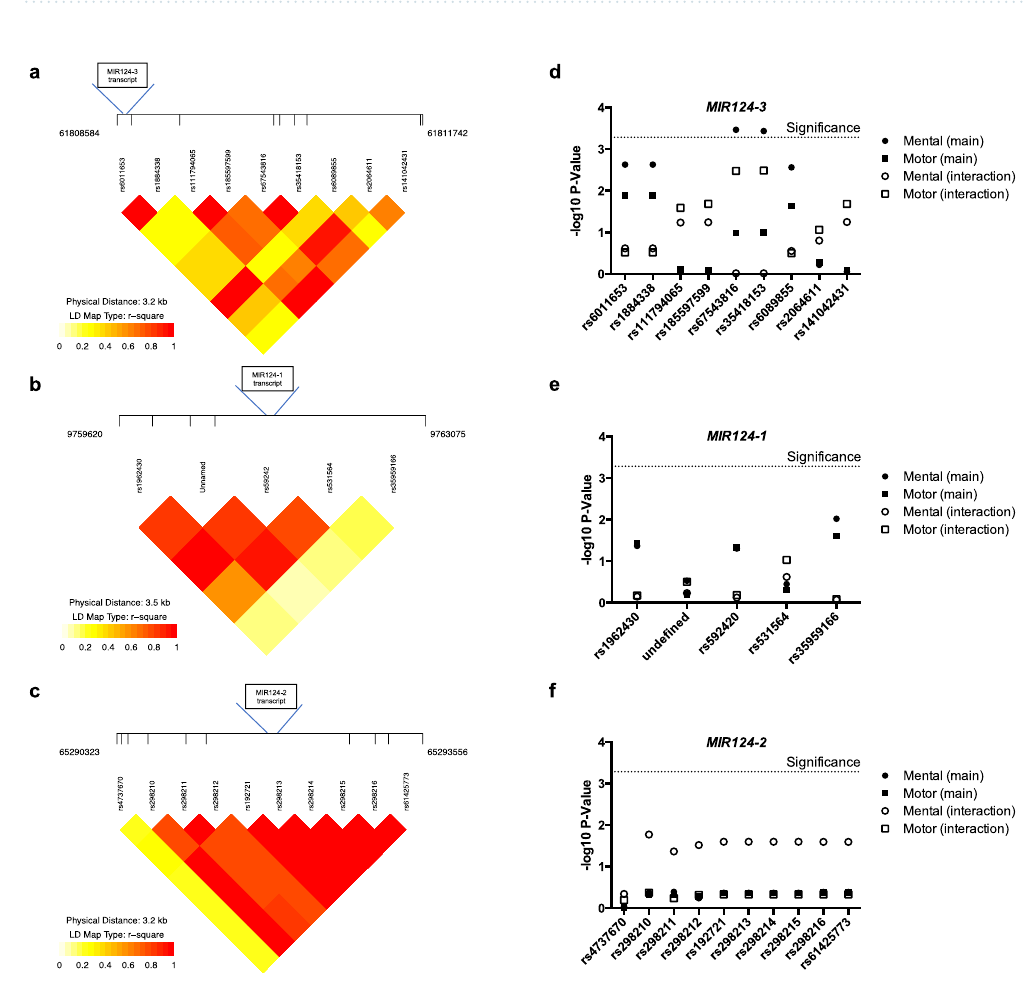
Figure 4. Association analysis of miR-124 SNPs with neurodevelopment phenotypes. ( a–c ) Schema of SNPs in relation to the genomic locus of miR-124-1, − 2, and − 3. Linkage disequilibrium (LD) patterns around miR-124 in the study population are shown. LD plot reflects pairwise R 2 among SNPs. ( d–f ) Negative log10 p-values for SNP associations with the mental composite score (Mental) and motor composite score (Motor) as a main effect and in interaction with As in the cord blood. Subjects =